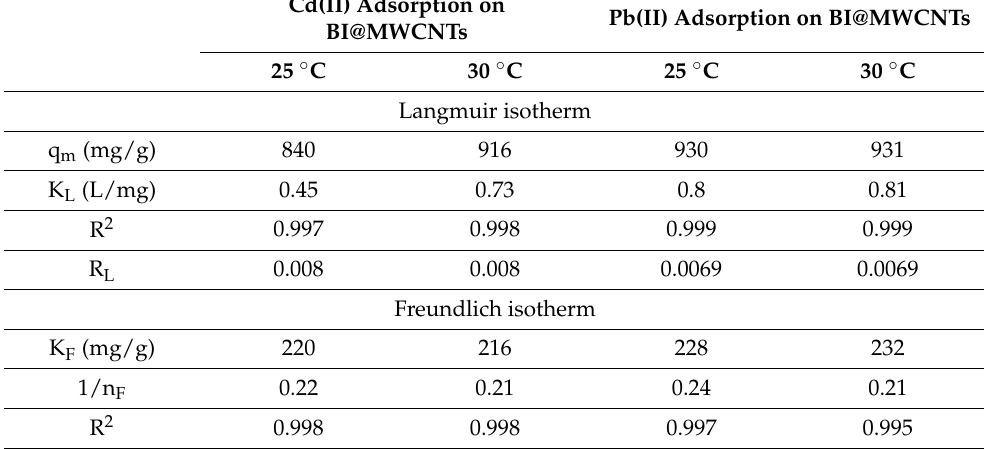
Table 4. The parameters of the adsorption isotherm for the adsorption of Pb 2+ and Cd 2+